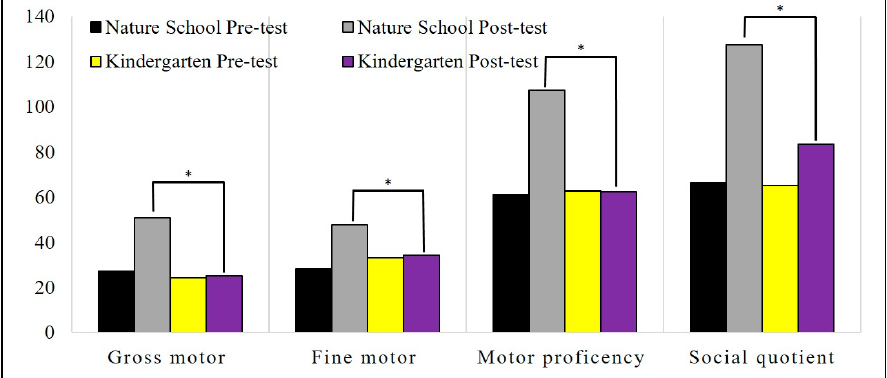
Figure 2. Descriptive statistics of the gross and fine motor proficiency and social quotient. * p ≤ 0.05.